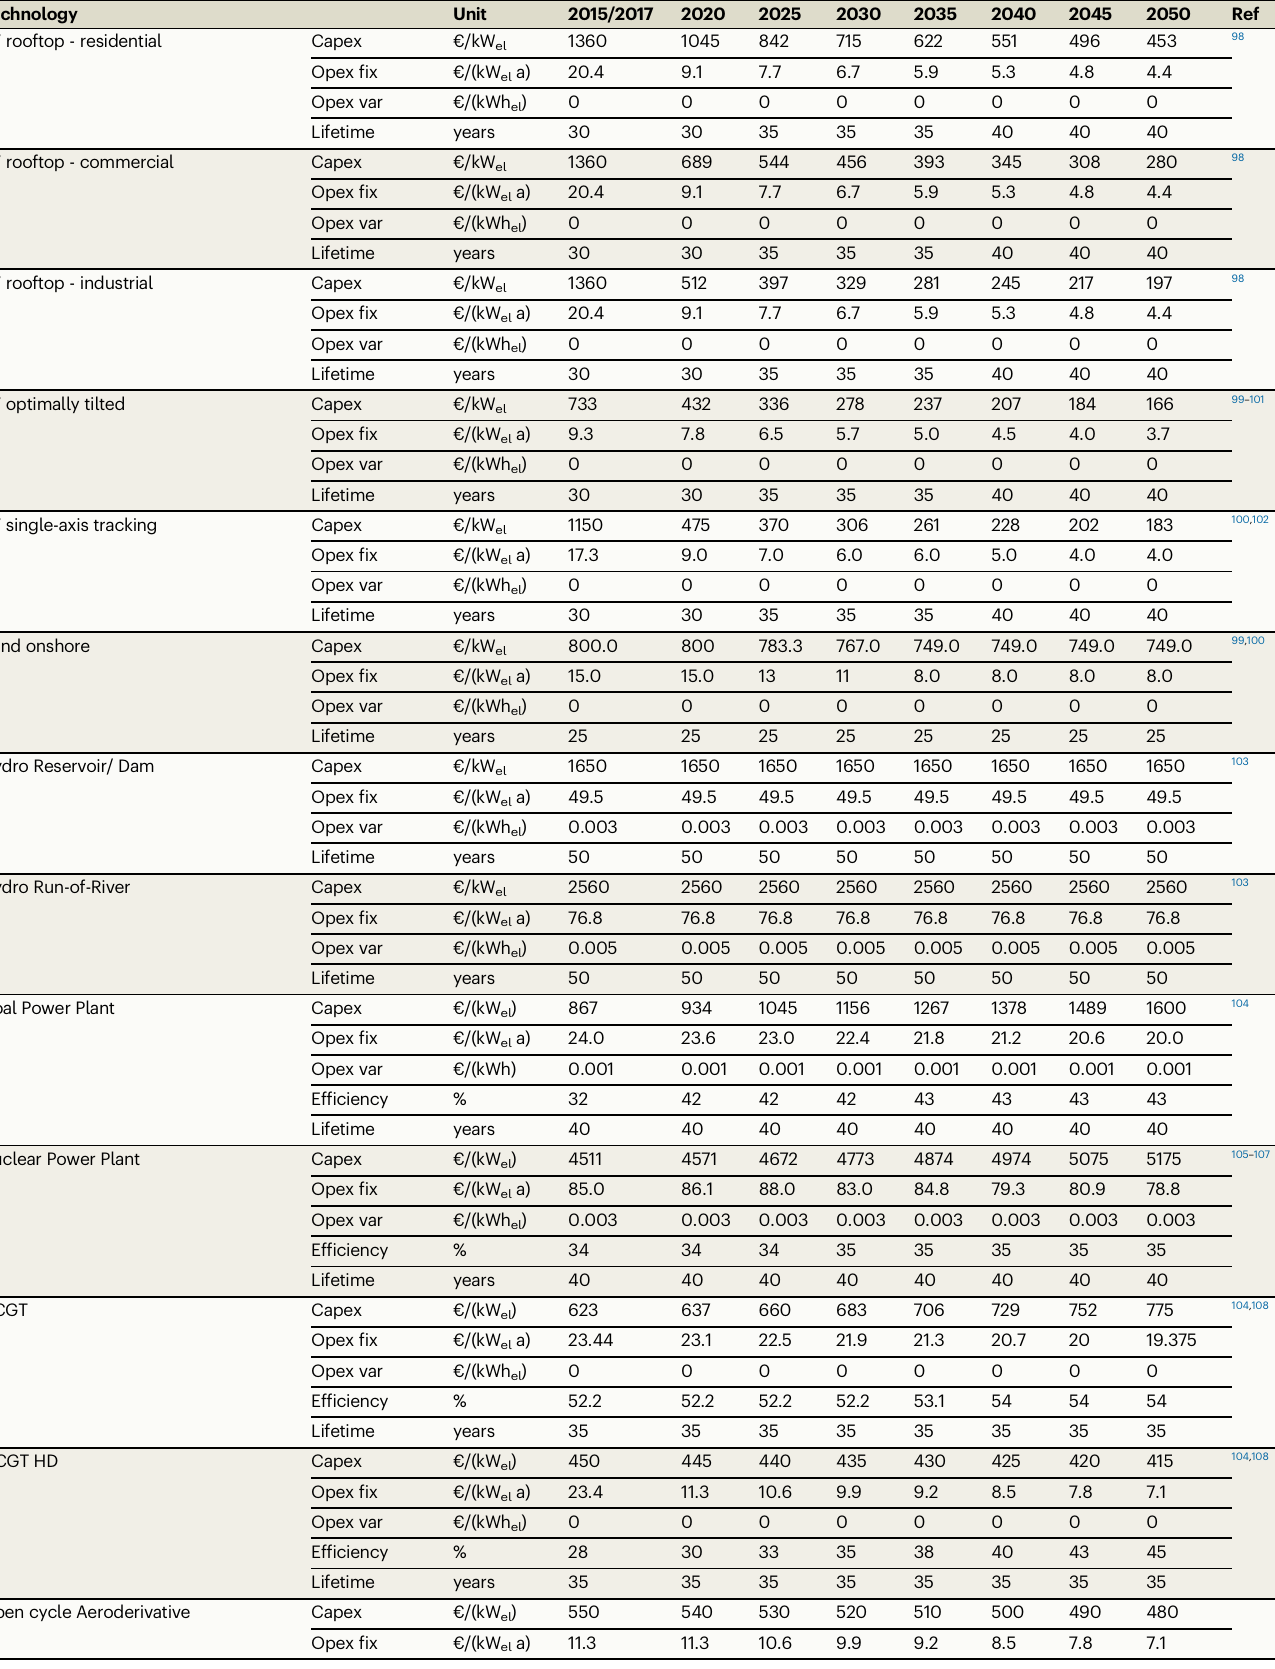
Table1 |Technical and fi nancial assumptions for keypowersystem technologies usedinthe Indianenergy transition from2015 to 2050 Technology PV rooftop - residential